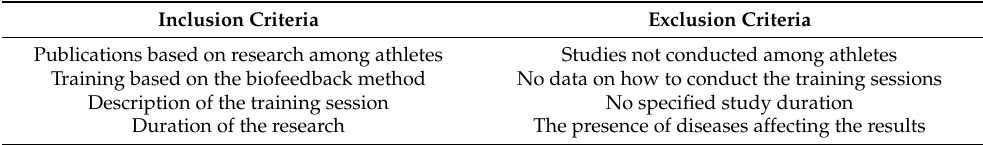
Table 2. Inclusion and exclusion criteria used for the